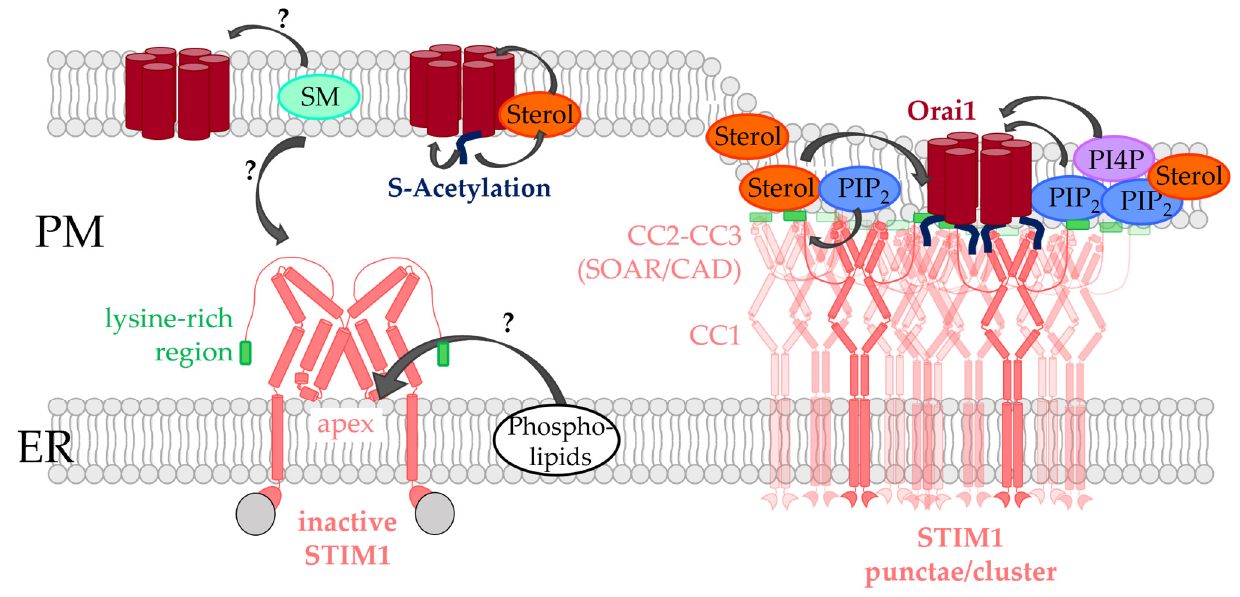
Figure 2. STIM1, Orai1, and their interplay with lipids. In the resting state, STIM1, located in the ER membrane, captures a quiescent and folded state, while Orai1, located in the PM, possesses a closed pore. After store-depletion STIM1 undergoes a conformational change, oligomerizes, and couples to Orai1. Although the interaction and function of the two proteins is sufficient for CRAC channel activation, their machinery is modulated by a variety of lipids including PIP 2 , PI4P, cholesterol, sphingomyelin and possibly also ER-phospholipids as outlined in detail in Section 4.